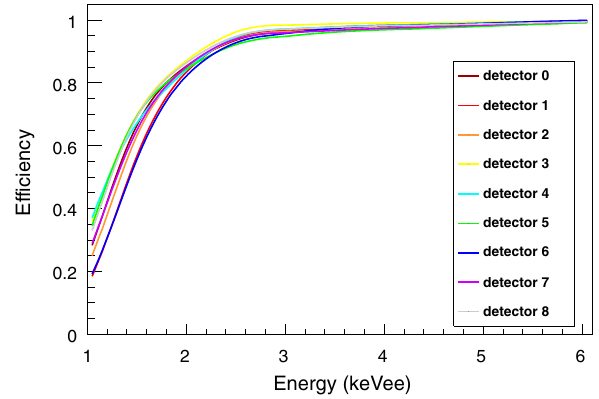
Fig. 1 Total efficiency for every ANAIS-112